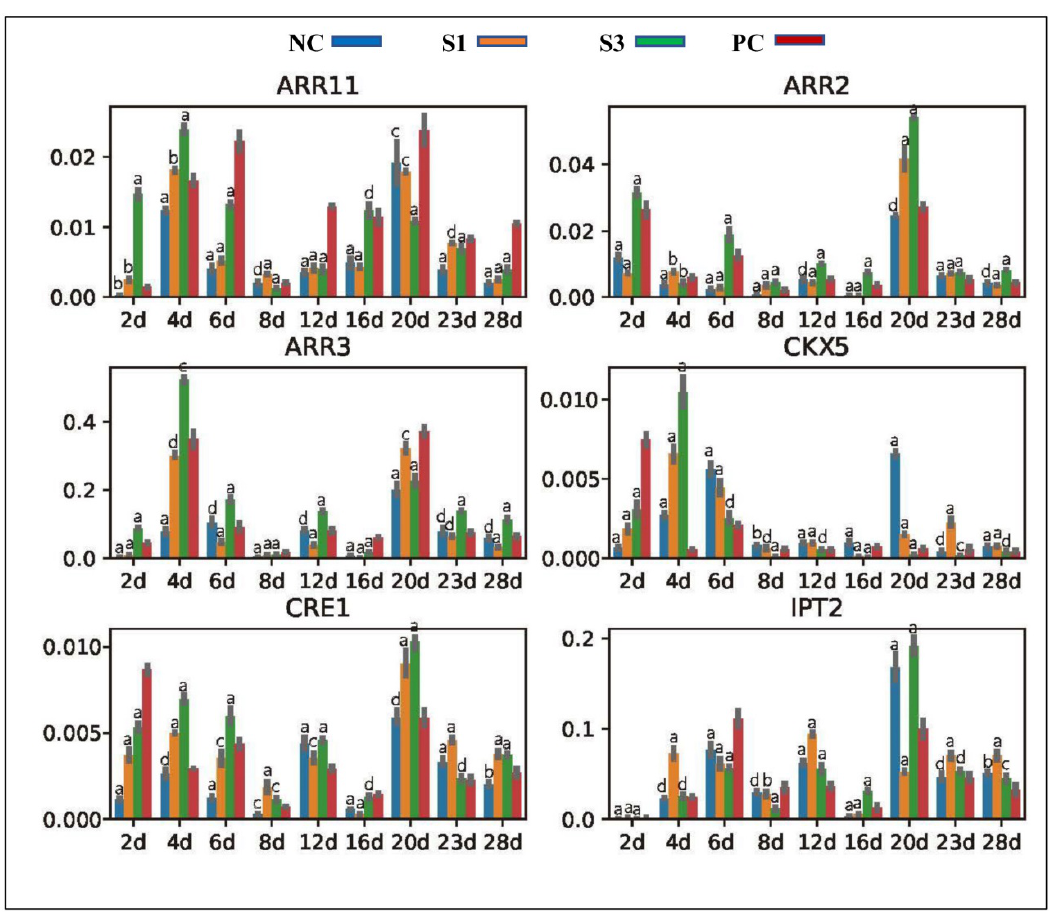
Figure 5. Expression patterns of CK synthesis—and signaling-related genes in differently treated samples. a, p -value < 0.001; b, p -value < 0.01; c, p -value < 0.05; d, p -value > 0.05.